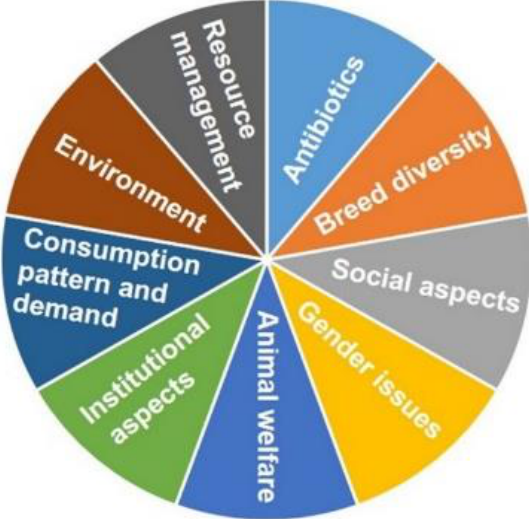
Figure 1. Schematic presentation of the challenges in sustainable antibiotic-free broiler production.